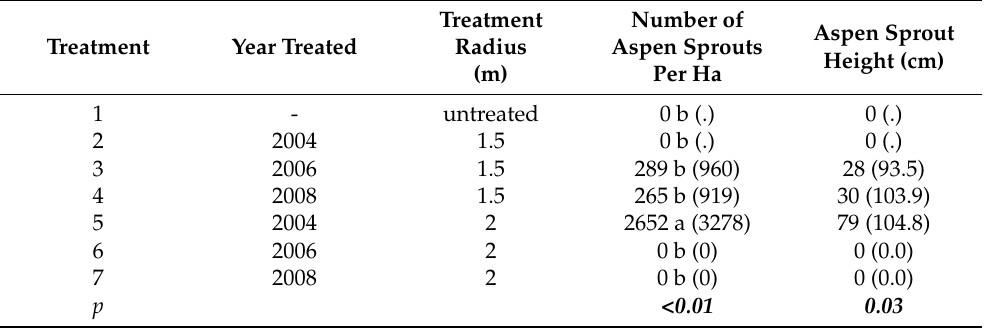
Table 2. Treatment effects on number and height of aspen sprouts within a 1 m radius plot centered on the crop spruce seedling in 2013 for the Judy Creek study. Letters in each column indicate significant differences detected using Scheffe’s Test at α = 0.05. SD shown in brackets. (despite ANOVA detecting a significant effect of treatments on aspen sprout height, Scheffe test did not indicate differences). Significant p values ( α = 0.05) are shown in bold.